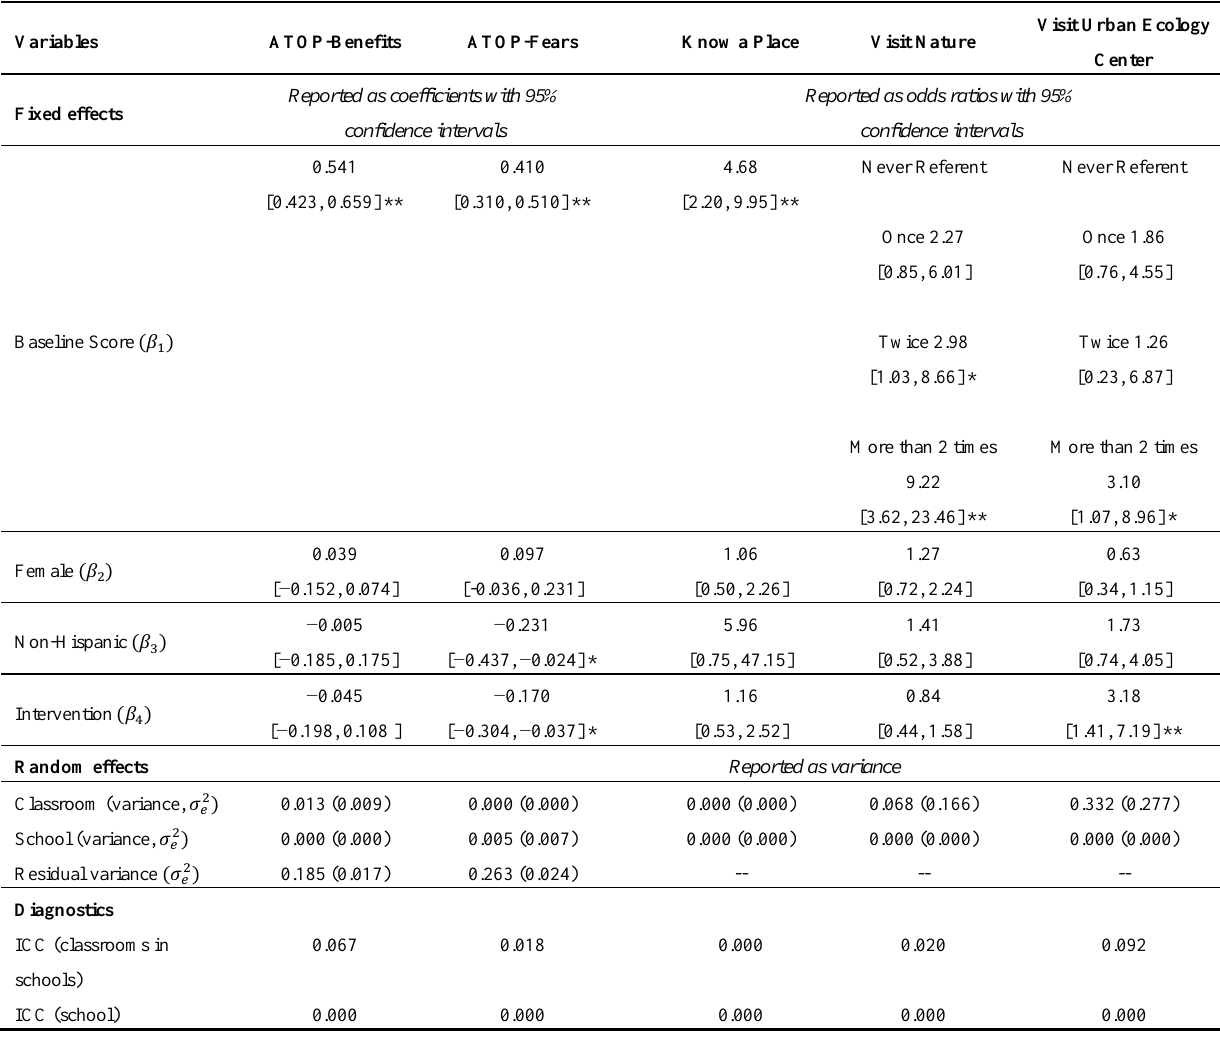
Table 3. Multilevel multivariable regression models measuring the impact of the neighborhood environmental education